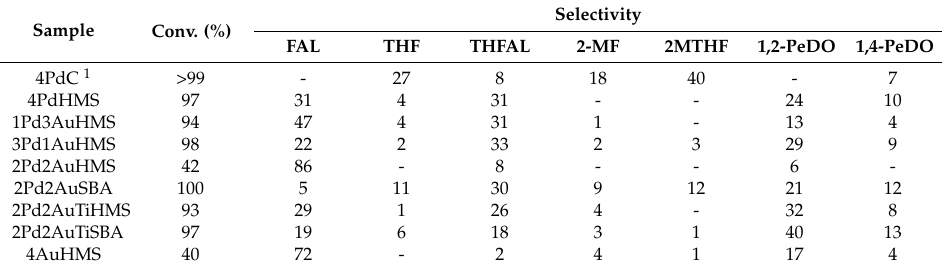
Table 1. Screening of mono- and bimetallic catalysts for furfural hydrogenation. Sample Conv.